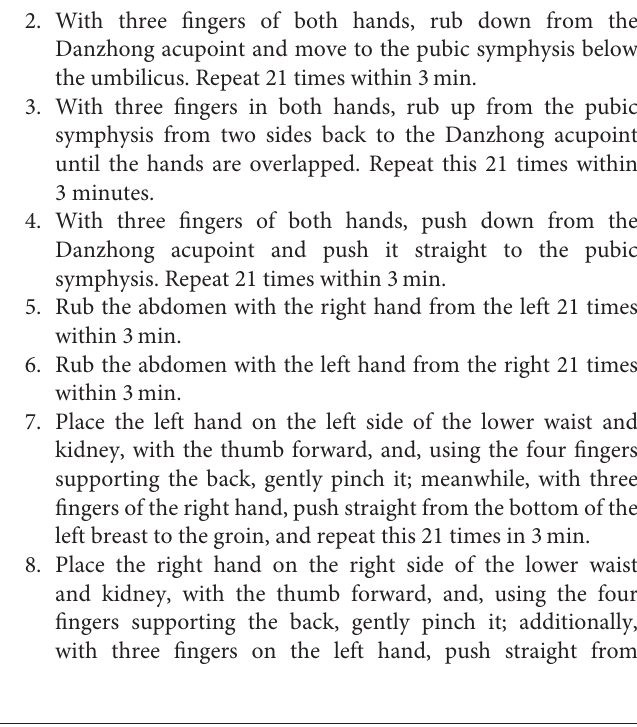
Frontiers in Medicine |